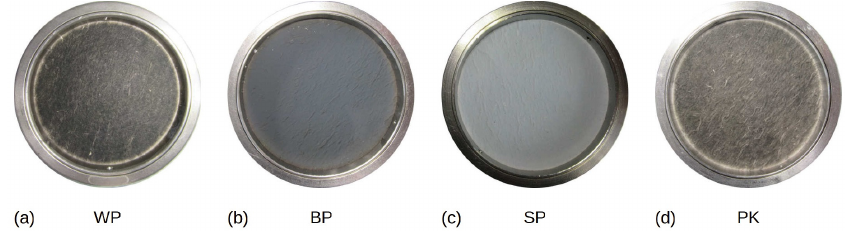
Figure 7. Filter for particle measurements (PM 2.5) after the experiments for the fuels used; ( a ) Wood pellets; ( b ) Bamboo pellets; ( c ) Wheat straw pellets; ( d ) Palm kernel shells.